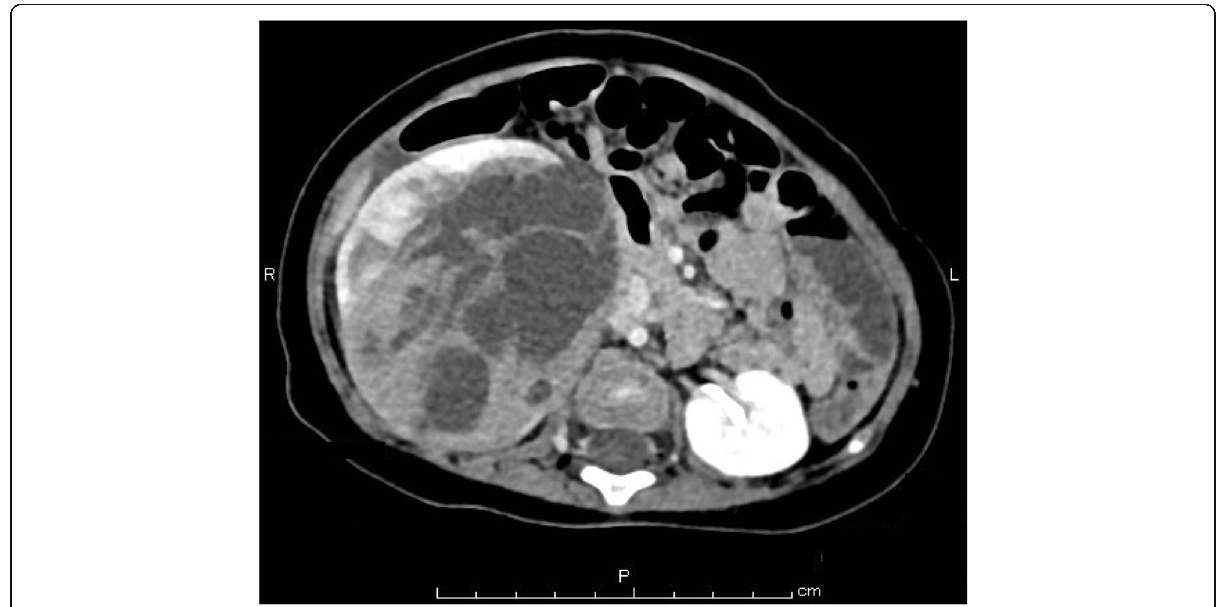
Fig. 1 Enhanced abdominal CT. Multilocular cystic mass located in the right kidney. The septal wall of the tumor was thickened. Multiple solid areas were identified within the